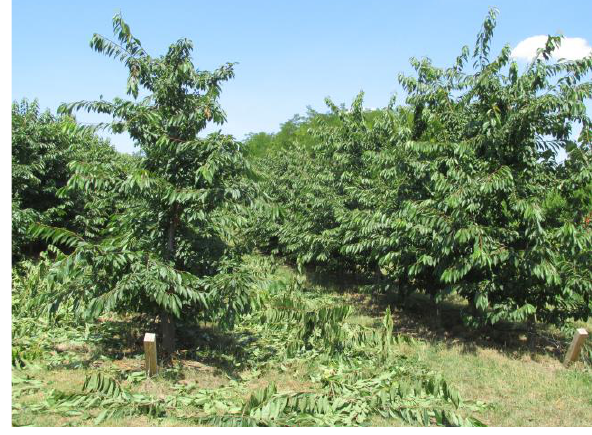
Figure 2. The orchard in fifth leaf (2019) after summer pruning.